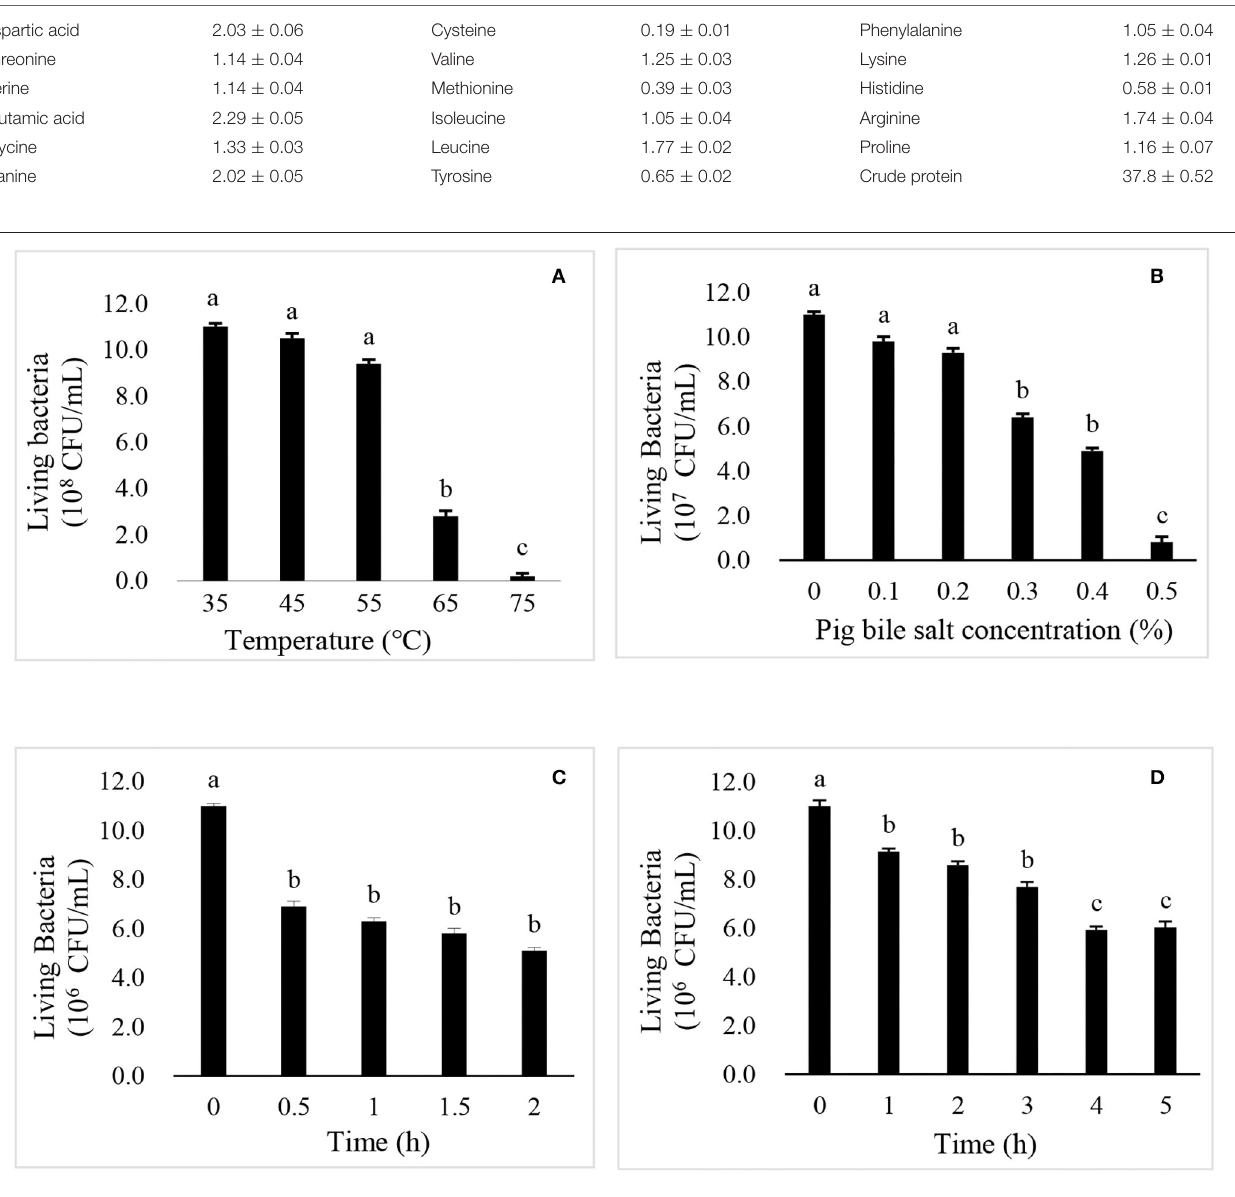
FIGURE 2 | The effects of temperature (A) , pig bile salts (B) , artificial gastric juice (C) , and artificial intestinal fluid (D) on the growth of R. mucilaginosa TZR 2014 .